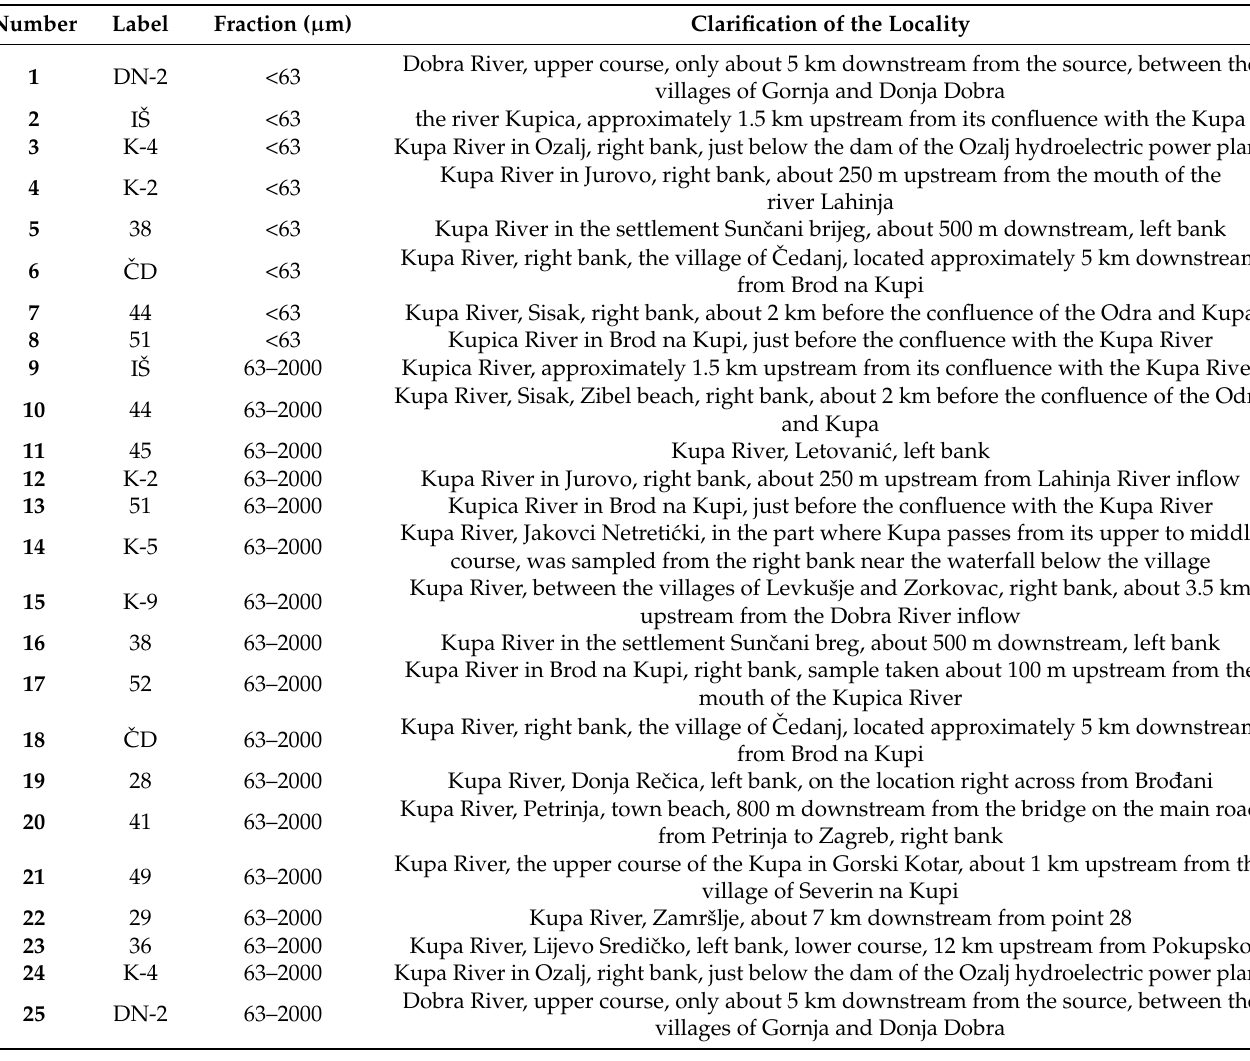
Figure 1. Sampling locations. Table 1. Sampling